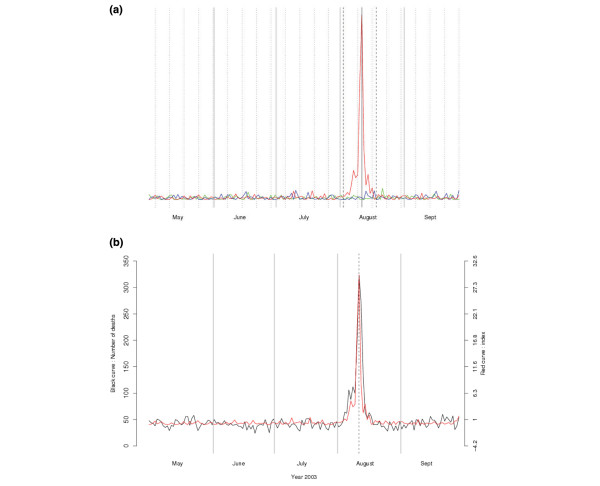
Heatstroke-related overmortality indicator: derivation sample. The three annual periods were superimposed and synchronised weekly. The vertical dashed lines define the heat-wave period (3–19 August 2003). (a) Best indicator calculated with the data of Cochin Hospital (2001, blue curve; 2002, green curve; 2003, red curve). (b) Cochin indicator (red curve) and Paris mortality (black curve).